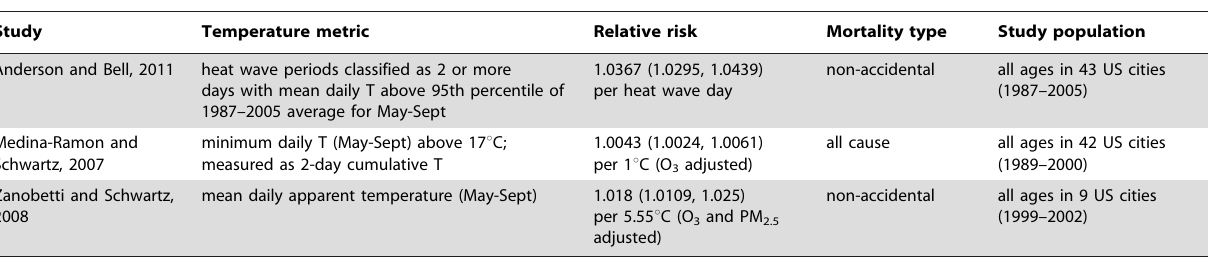
Table 2. Description of heat response